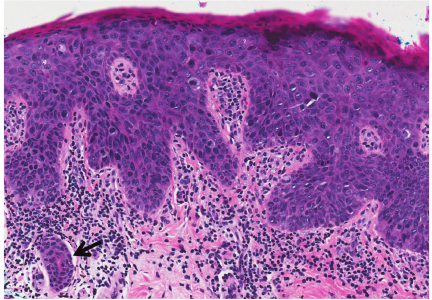
Figure 20: Bowen disease: medium-power magnification showing skin with full thickness epidermal dysplasia which is characterized by loss of the nuclear polarity, nuclear pleomorphism, and mitoses at all levels. The undulating deep epidermal contour and presence of eccrine ducts that have been colonized by the tumor cells (arrow) can potentially mimic invasion. (H&E, ×